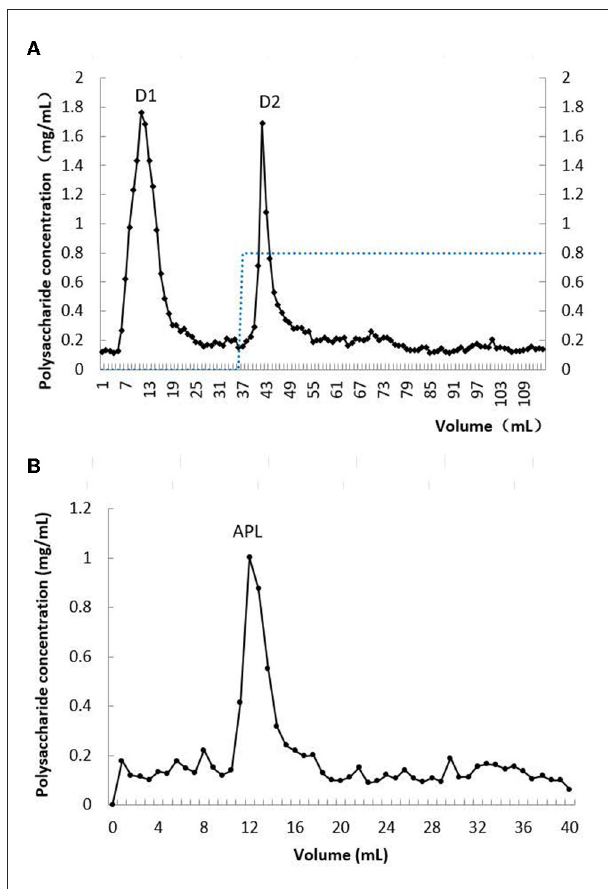
FIGURE1 Chromatographs of crude extract of A. polytricha . (A) Profile of elution from DEAE-cellulose column; (B) profile of elution from Sephadex 200